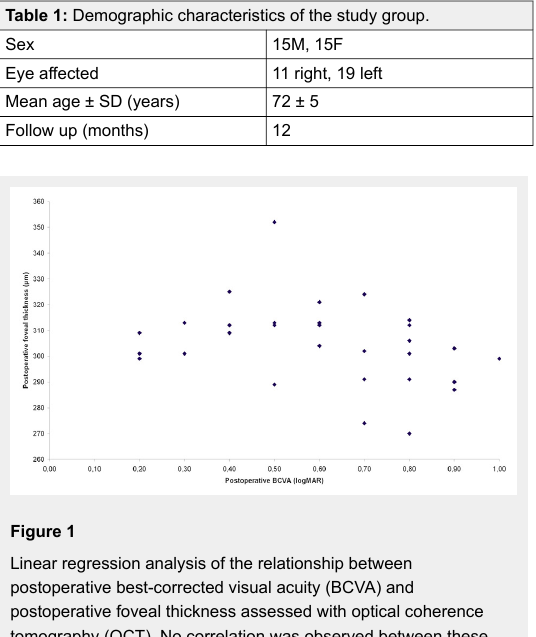
Table 1: Demographic characteristics of the study group.